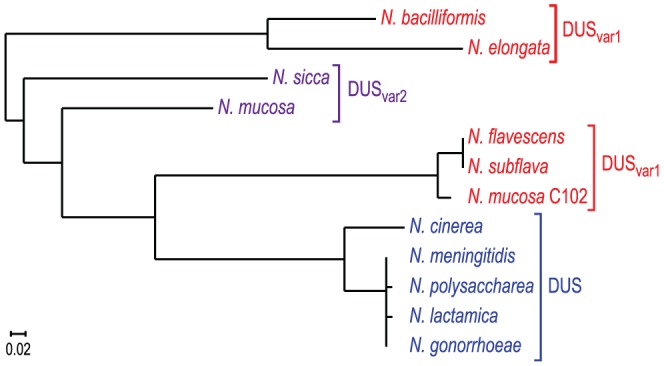
Human Neisseria species harbouring different DUS variants have different cognate ComPs.A maximum likelihood phylogenetic tree [36] based on the sequences of mature ComP found in human Neisseria species shows that species harbouring the same DUS (highlighted in the same colour) have highly conserved ComPs.